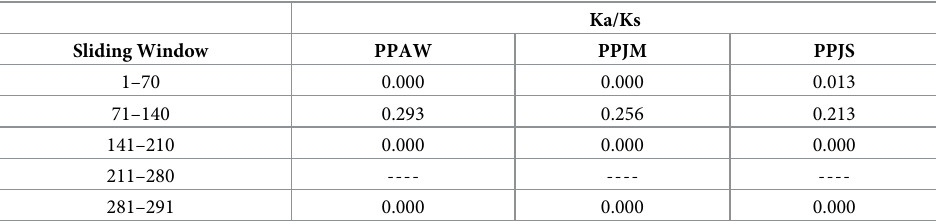
Ka/Ks were plotted for every 70 codons. Values greater than one suggest the potential for positive selection. ----indicates a lack of polymorphic data in the window to calculate a Ka/Ks